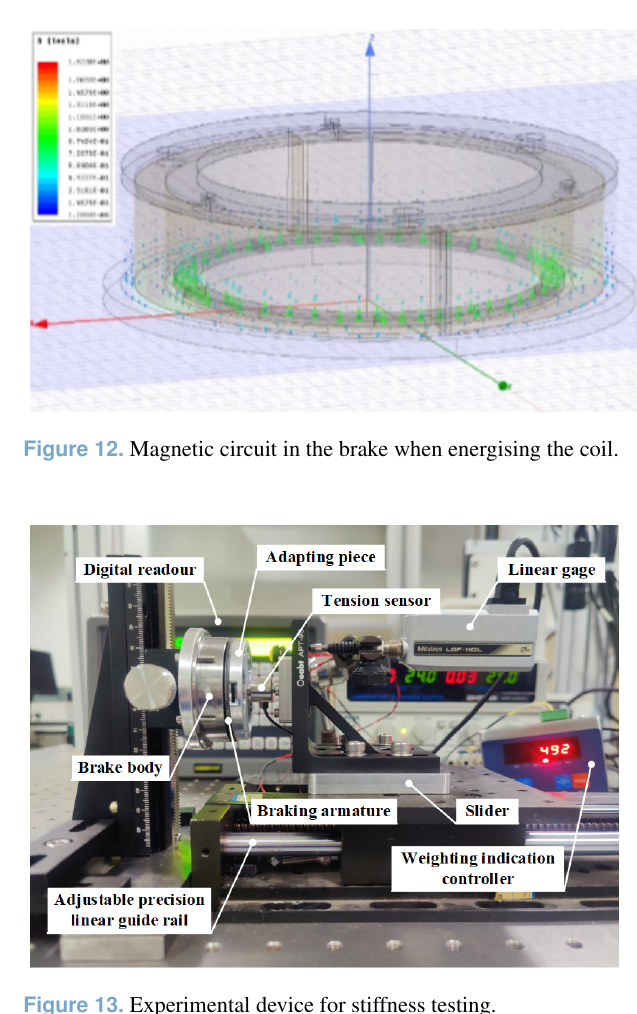
Figure 15. Experimental device for permanent magnet suction test-